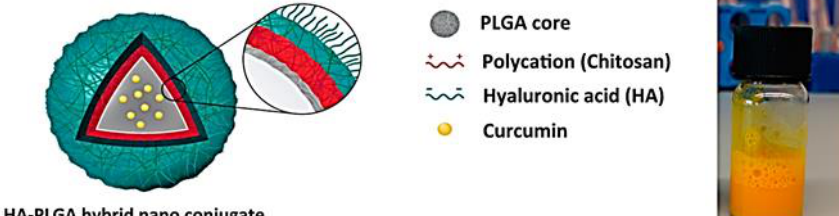
Figure 9. Mechanistic system of Eudragit-coated pellets encapsulating nanoparticles for colon-spe- cific targeting [93], reproduced with permission from Elsevier.